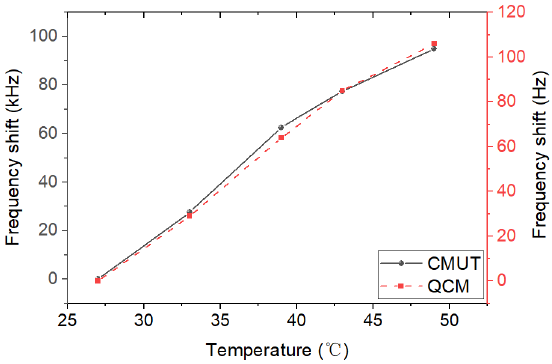
Figure 10. Frequency shifts of the CMUT and QCM sensors as a function of temperature.